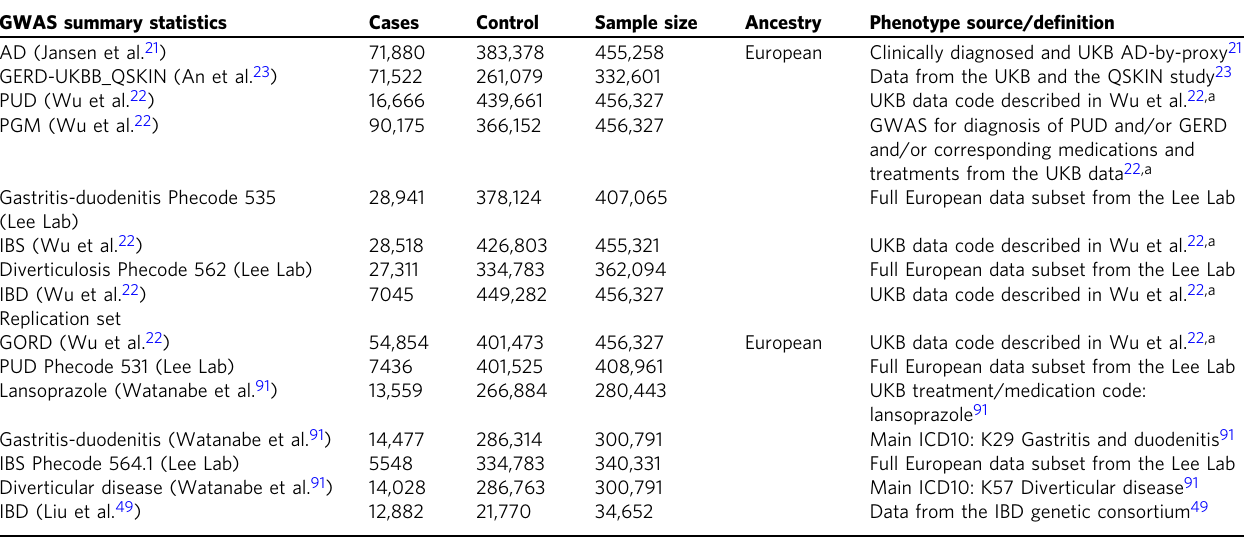
Table 1 Summary of GWAS data sets